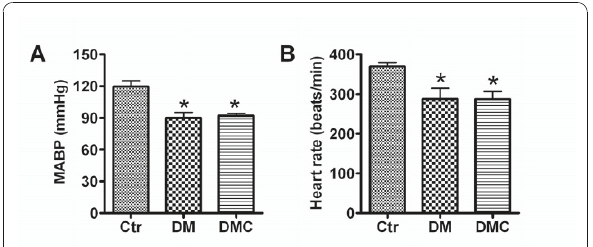
Figure 2 Resting mean arterial blood pressure (MABP) and heart rate (HR) in control, DM model rats, and DM rats treated with DMC . Data are presented as Mean ± S.E.M. * mean value was significantly different from that of the control group ( P < 0.05). n =